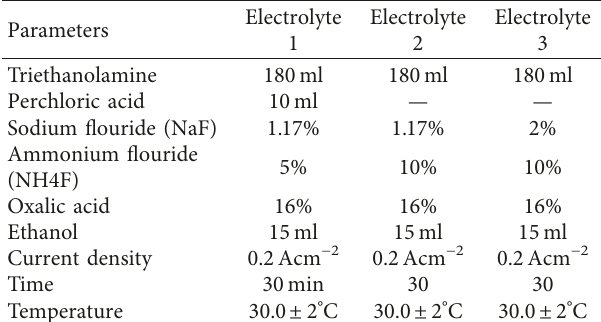
Table 1: Electropolishing parameters.